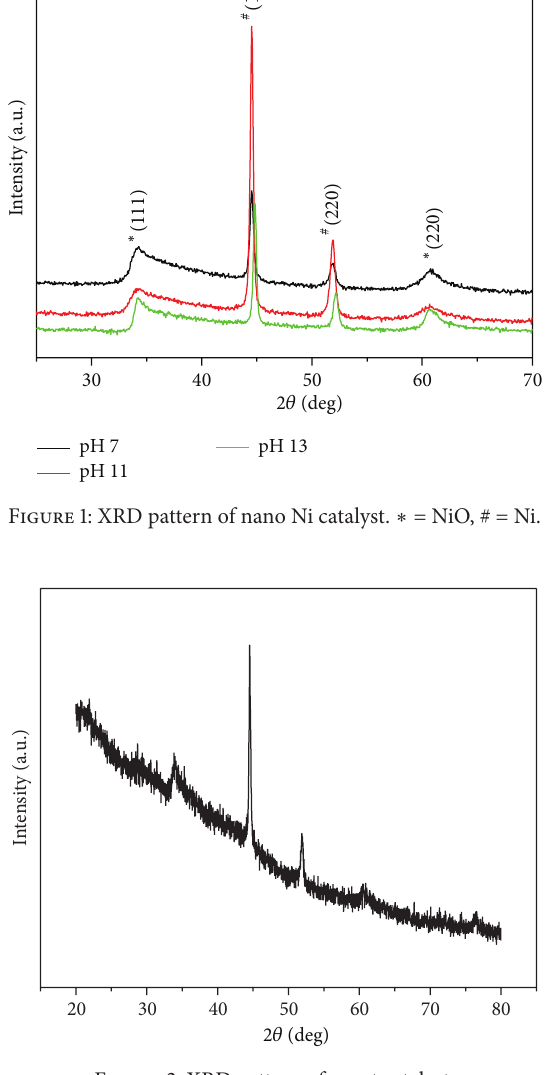
Figure 2: XRD pattern of spent catalyst.